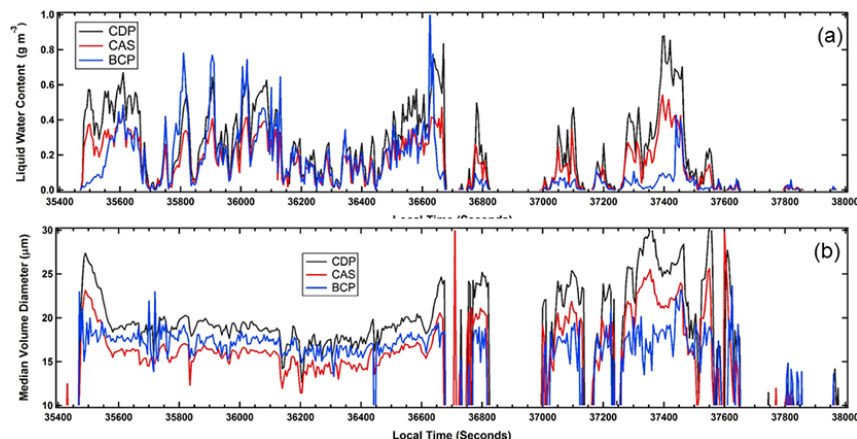
Figure 11. These time series of liquid-water content (LWC) in the top panel and optical median volume diameter (MVD) in the lower panel are over the same interval of time as shown in Fig. 10b.